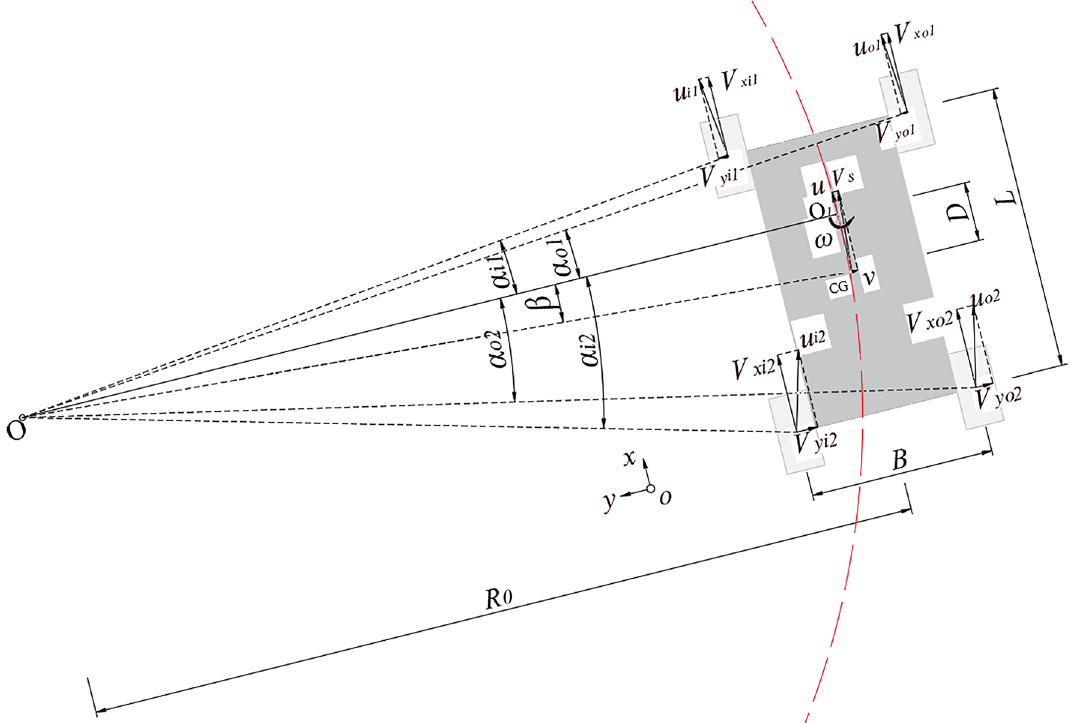
Figure 1. Schematic of the skid-steered four-wheel drive